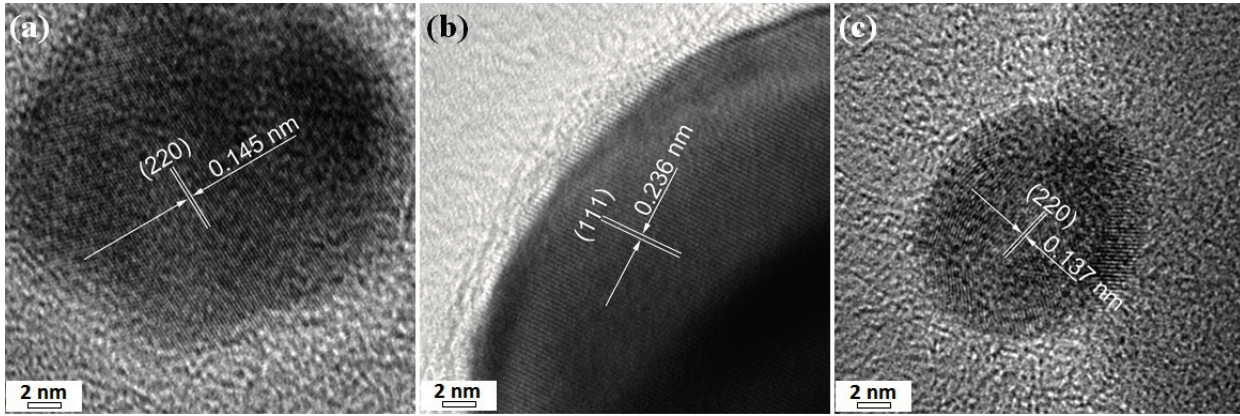
Figure 7. HR-TEM analysis for synthesized samples: ( a ) Ag NPs; ( b ) Au NPs; and ( c ) Pd